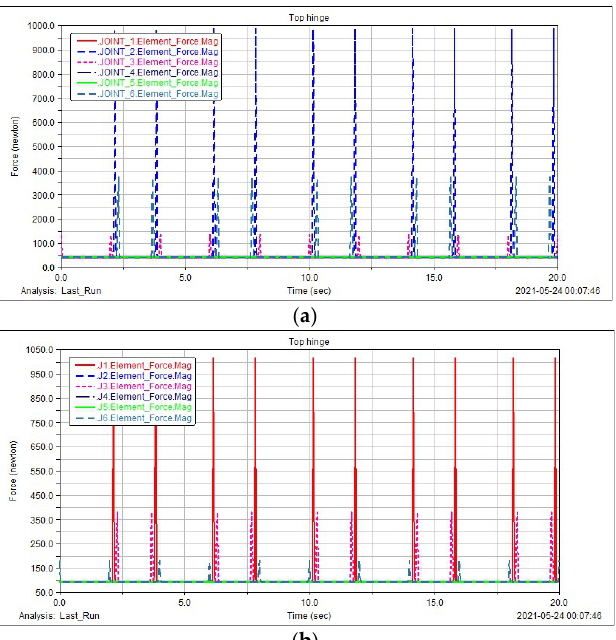
Figure 11. Stress curve of upper and lower platform hinges. ( a ) Stress curve of upper platform hinge. ( b ) Stress curve of lower platform hinge.